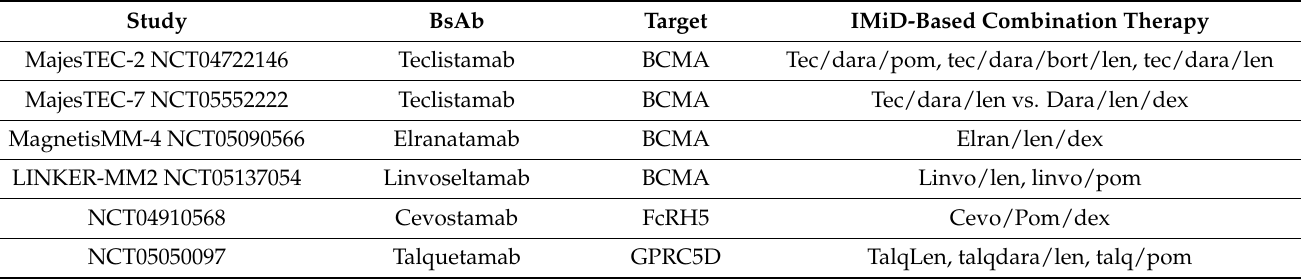
Table 2. Ongoing studies of a BsAb in combination with an IMiD in